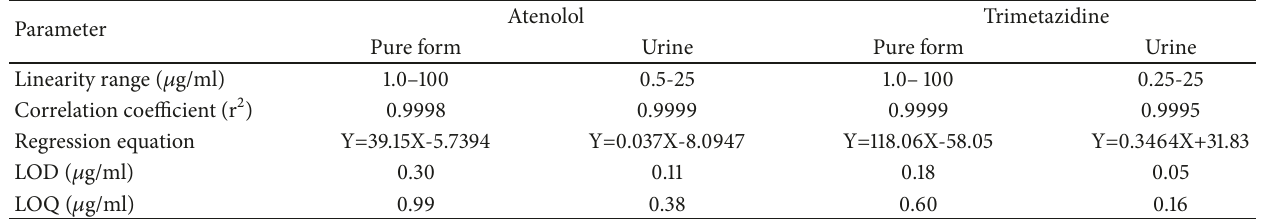
Table 1: Analytical performance data for HPLC determination of atenolol and trimetazidine in pure form and urine samples.